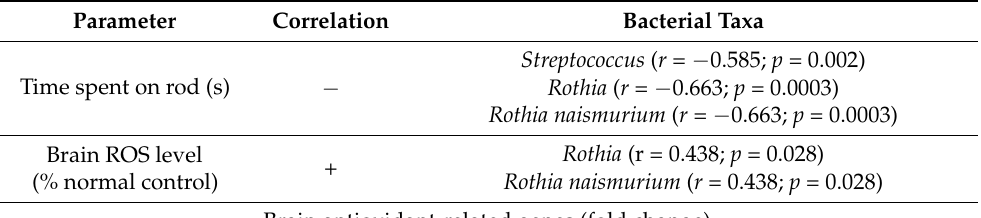
Figure 9. Comparison of the abundance of specific bacterial species identified in rats with 6-OHDA- induced Parkinson’s disease after 8 weeks of supplementation with the low-dose mangosteen pericarp (LMP) and high-dose mangosteen pericarp (HMP). Results are average ± SEM for n = 5 rats/group and were analyzed using unpaired t -tests. Table 4. Correlations of bacterial taxa with parameters of motor function, antioxidant and mitochon- drial gene expression, and inflammatory cytokines after 8 weeks of supplementation in the rat model of